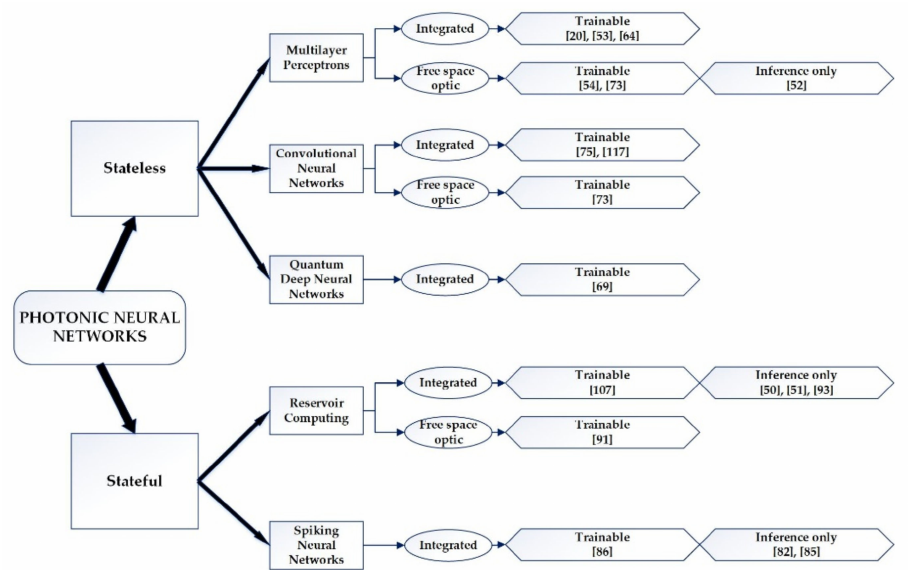
Figure 1. Photonic neural networks classification according to their architecture (stateless or stateful), their design (integrated or free-space optic) and their training ability, presented until 2019.